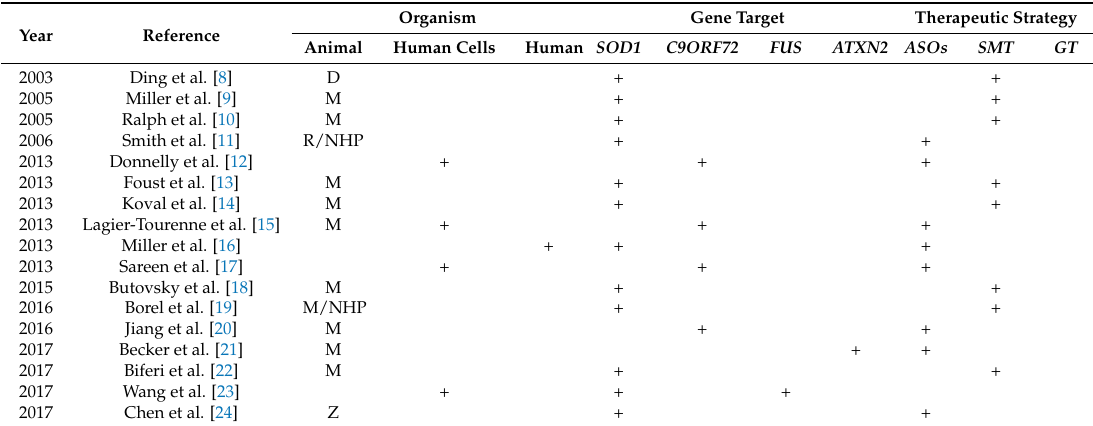
Table 1. Main RNA-therapy studies in amyotrophic lateral